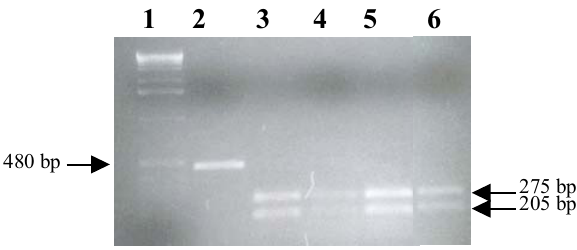
Fig. 3. Analysis of Rsa I digestion products on 1.4% aga- rose gel. Lane 1, 1 kb marker (Gibco-BRL). Lane 2, nest- ed PCR product 480 bp (before digestion by Rsa I). Lanes 3, 4, 5 and 6, digestion products from pepper cv. Baker, cv. Baklouti, cv. D’hirat and cv. Beldi